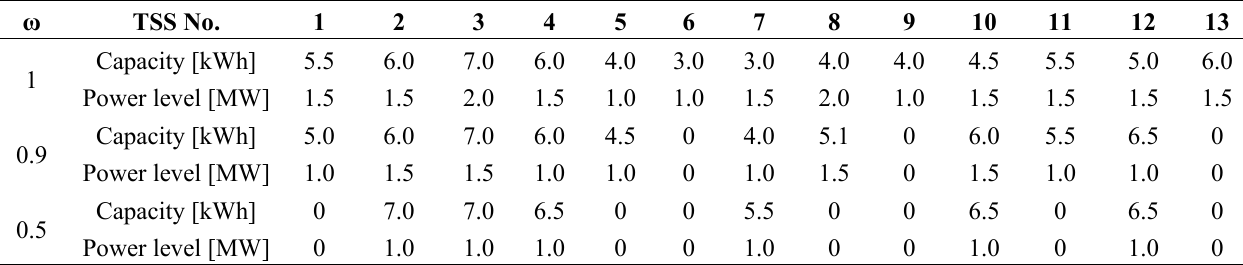
Table 4. Conventional and optimized schemes of low traffic